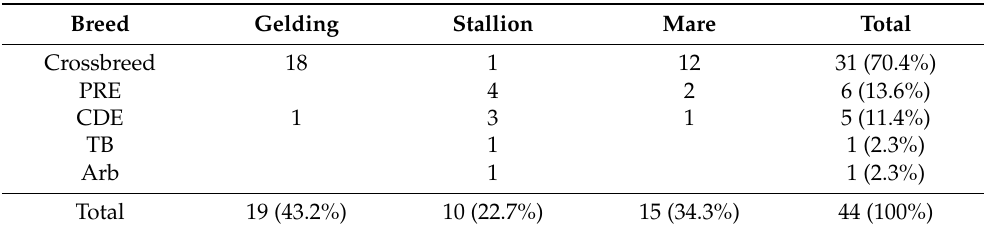
Table 1. Breed and sex characteristics of the 41 horses subjected to 44 laparoscopies. In parentheses, percentage with respect to total laparoscopies. Breed Gelding Stallion